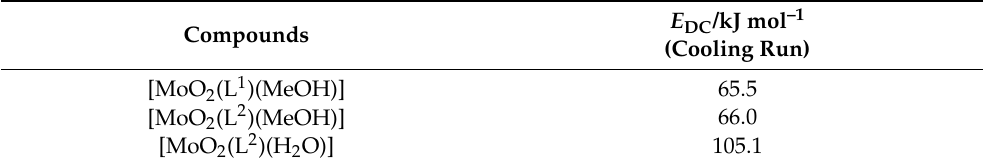
Table 2. Activation energy values for the DC conductivity in the cooling cycle of the prepared complexes with observed structural